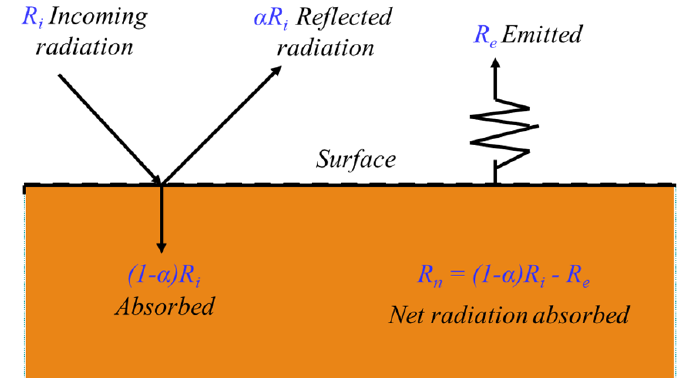
Figure 5. Radiation balance at the surface